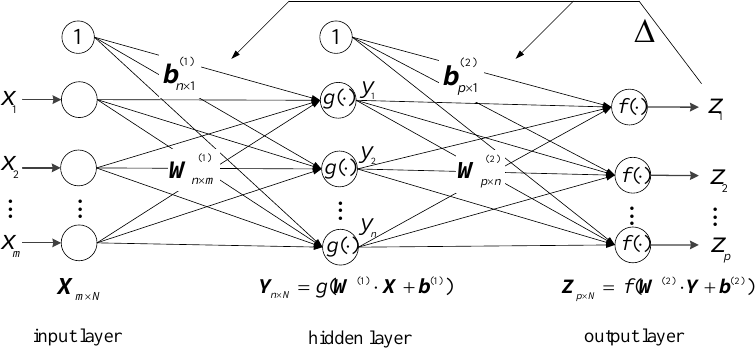
Figure 1. General procedure for regressing with the three-layer feedforward neural network (TFNN). However, the optimal weight and bias values in Figure 1 and Equation (13) usually need to go through a series of training sessions before being finally determined. A popular learning algorithm, back-propagation (BP), is usually used to train the TFNN [39,40]. In the training process with BP, the error energy of the neurons in the input layer and hidden layer transmitted to the output layer can be summed as a cost